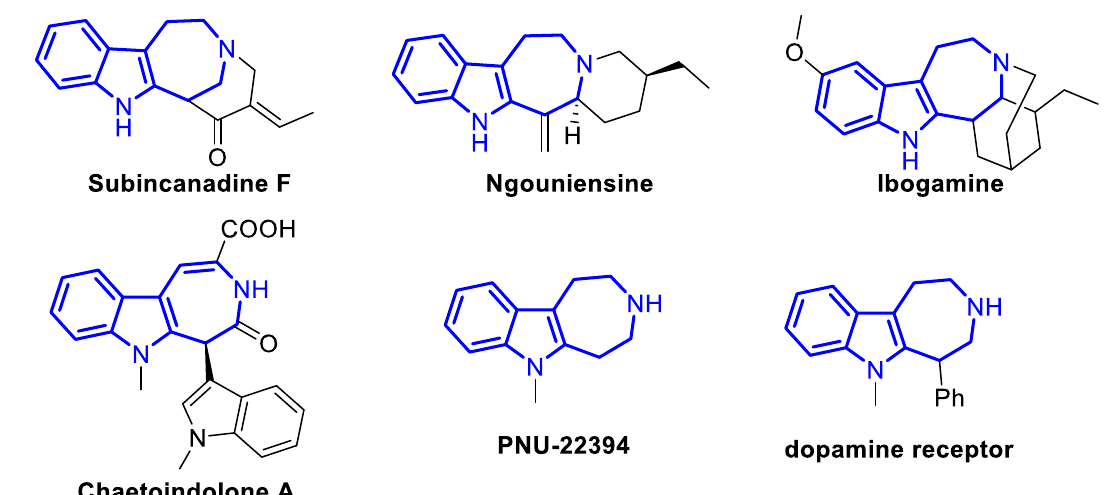
Figure 1. Natural products and pharmaceuticals containing azepine structures.